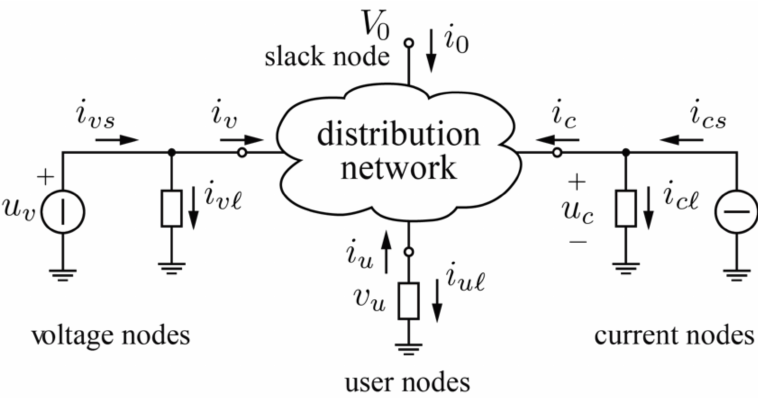
Figure 3. Concept scheme of